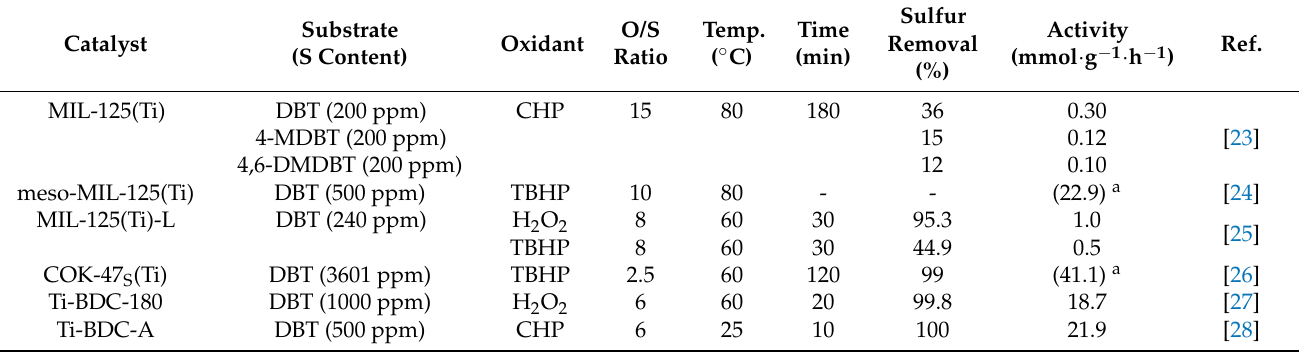
Table 1. Comparison of catalytic performance over various Ti-MOFs in the ODS reactions of model fuel oil.